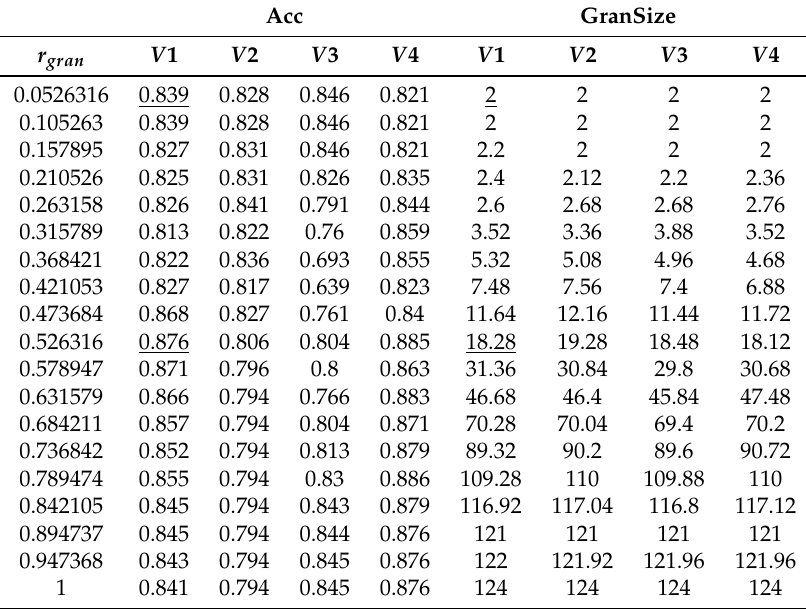
Table 24. 5 × CV-5; The result of experiments for four variants of the Naive Bayes classifier; data set Hepatitis; Concept dependent granulation; r gran = Granulation radius; nil = result for data without missing values; Acc = Accuracy of classification; GranSize = The size of data set after granulation in the fixed r .